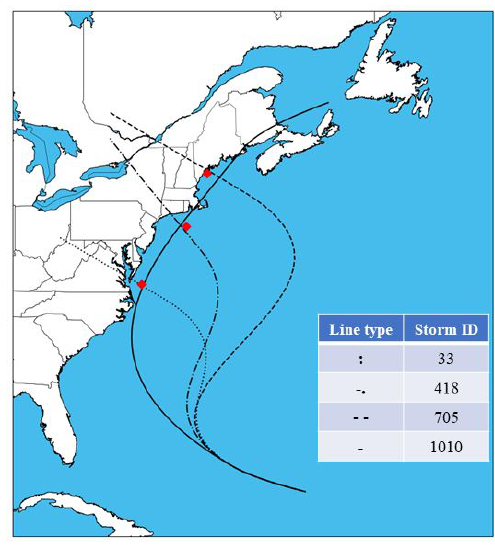
Figure 9. The selected bypassing storm 1010 and three landfalling storms 33, 418, and 705 for evaluating the neural network storm surge forecast model. The diamond symbol indicates three save points, and their index can be found in Figure